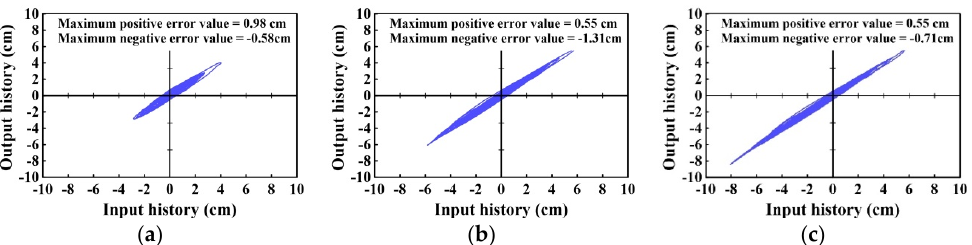
Figure 6. Seismic displacement control applied to column structures.